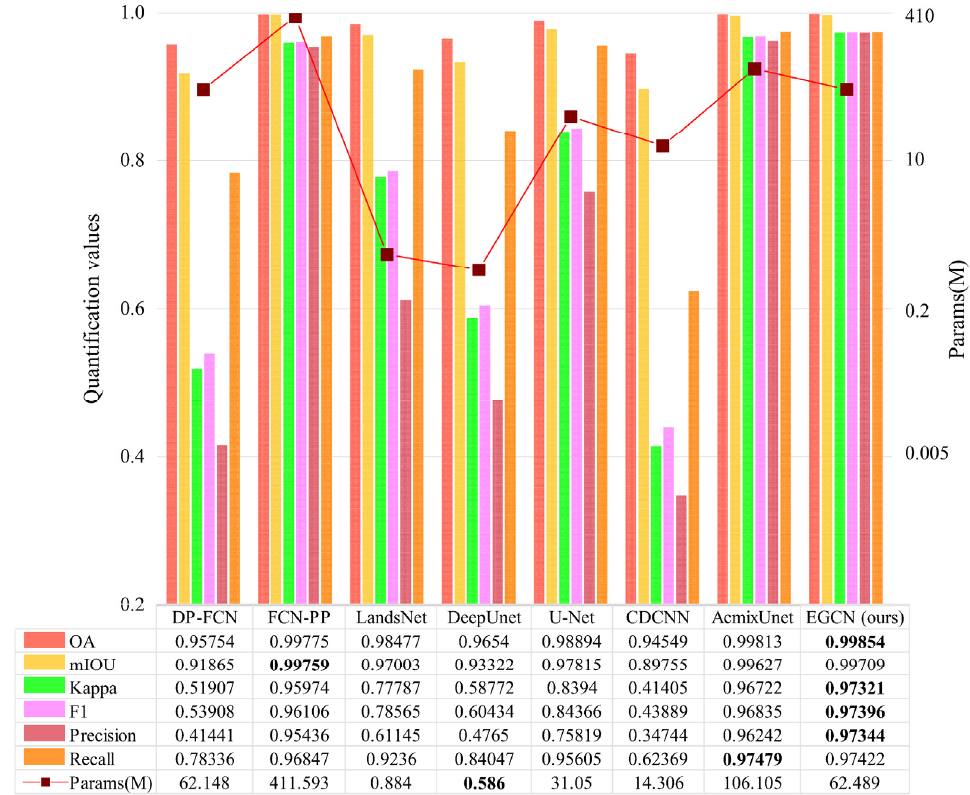
Figure 11. Test accuracy evaluation and comparison among 8 algorithms. Bold values mean the highest number of the corresponding evaluation criterion.